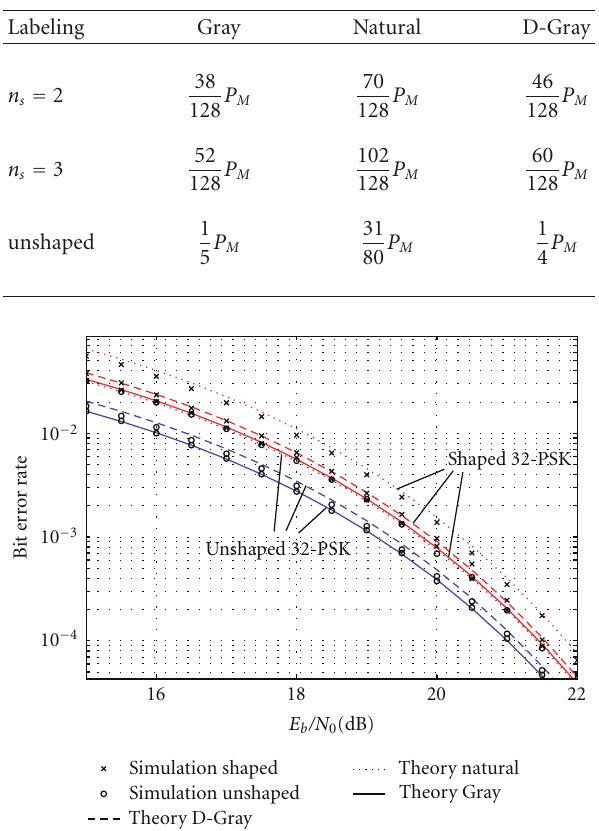
Figure 10: Bit error rate performances of the 32-PSK TS with n s = 3 and the three bit labelings. The corresponding unshaped 32-PSK performances are also plotted for